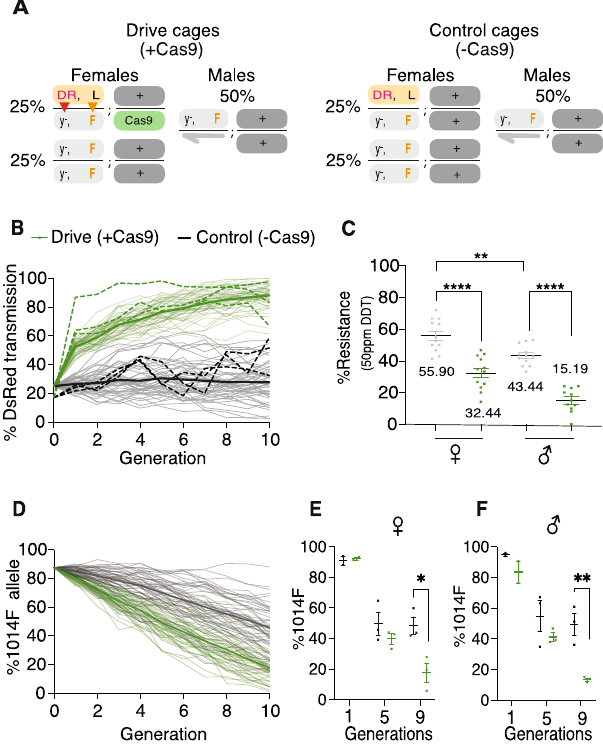
Fig. 3 Dynamics of 1014 F conversion over 10 generations in caged populations. A Virgin ‘ master females ’ carrying the y <CC|pF|> allelic-drive (DR) and Cas9 were seeded among receiver para L1014F fl ies at a ratio of 25%:75% ( n = 100; N = 3). B Model-predicted dynamics of the y <CC|pF|> drive element. Mathematical simulations were run using fi tted drive parameters and estimated fi tness costs. 50 stochastic predictions are plotted in thin lines and their mean in thick lines. Experimental data from 3 independent replicates was overlayed as dotted lines. C Resistance to 50 ppm DDT was tested separately for generations 9 – 12 (Fig. S6E, F) and averaged. Percent resistance to DDT exposure (assayed by survival) in the presence (drive) or absence (control) of Cas9 combined for all 4 generations is plotted and analyzed using one-way ANOVA followed by Sidak ’ s multiple comparison tests. D Dynamics of 1014F allelic frequency was modeled separately from the y <CC|pF|> element. The model predicted a decrease in 1014F levels for both control and drive populations with faster decline in presence of Cas9. E , F The proportion of the 1014F allele was measured by deep sequencing of females and males at generation 1, 5 and 9. The percentage of 1014F alleles in the presence (green dots) or absence (gray dots) of Cas9 was plotted and analyzed using multiple unpaired t tests. Data plotted as mean ±